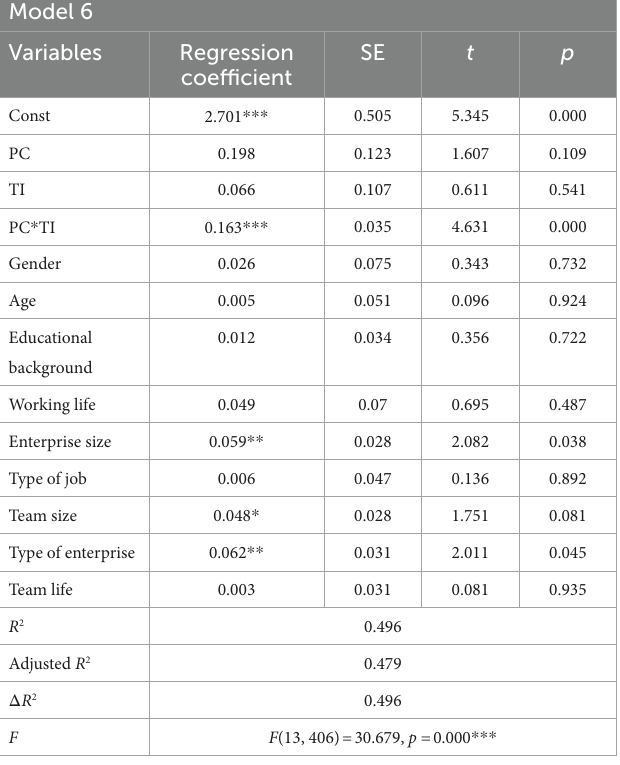
TABLE 8 Regression analysis of the moderating effect of task interdependence. Model